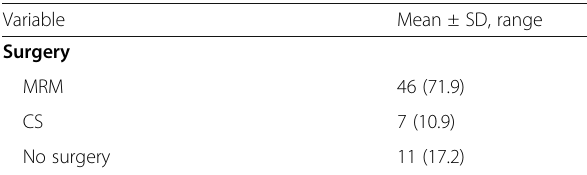
Table 1 Patients ’ and disease characteristics ( n = 64)